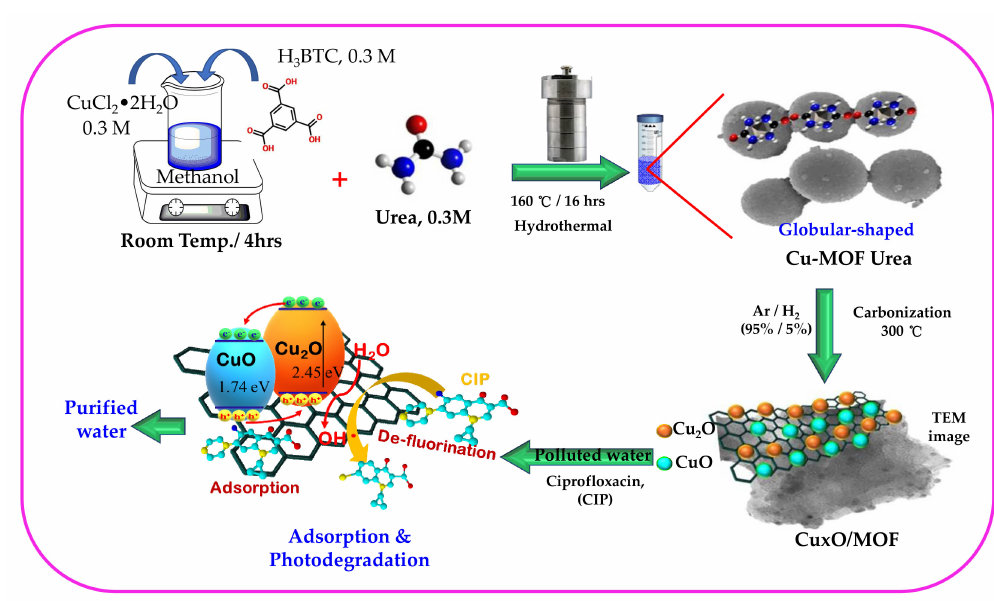
Scheme 1. Illustration of the photo-activation of Cu x O/MOF for the adsorption and photodegrada- tion of